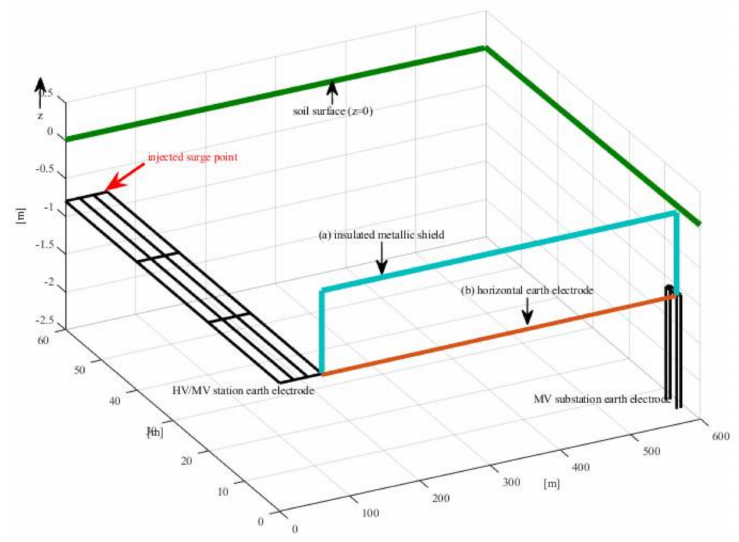
Figure 3. Scenario 2—Direct lightning stroke to an HV/MV station. ( a ) Interconnection realized by insulated metal shields; ( b ) Interconnection by a horizontal earth